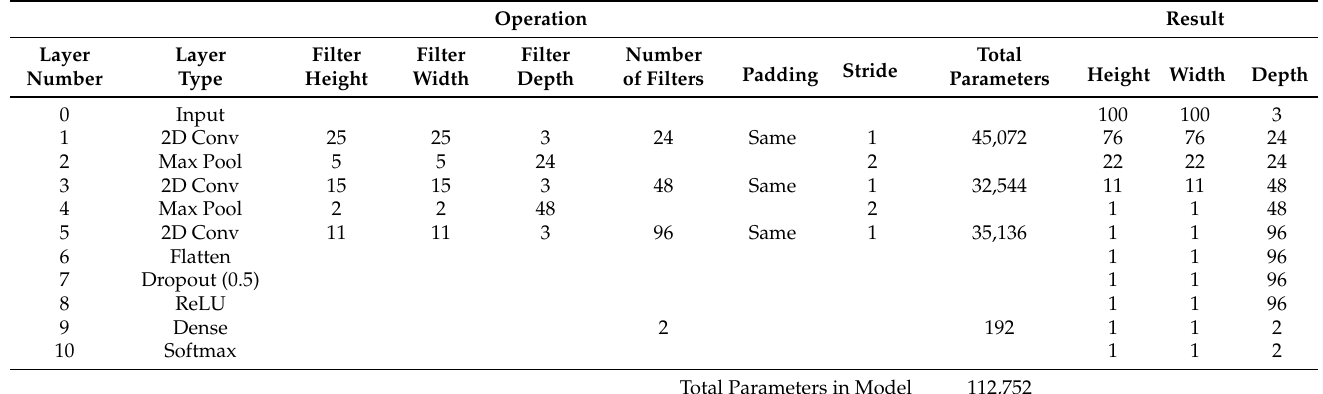
Table 1. Details of CNN Architecture A based on Ref. [44].